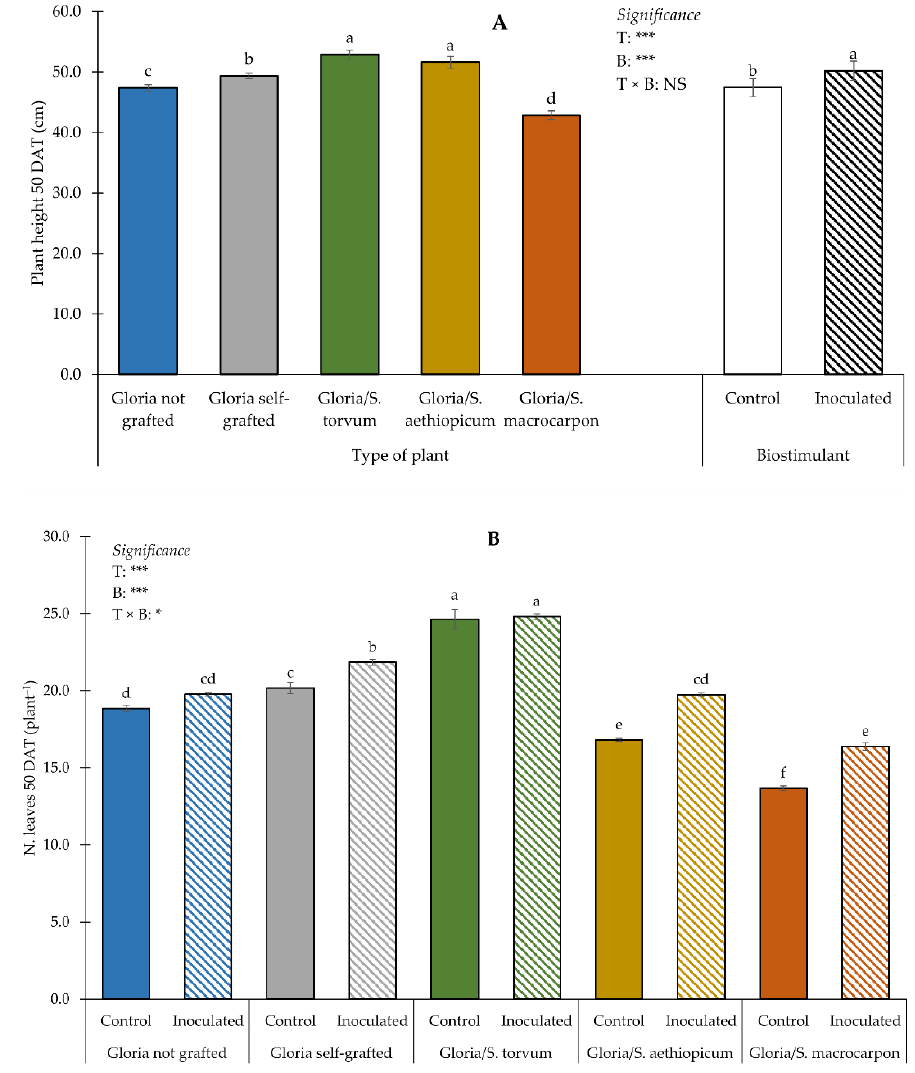
Figure 1. Influences of the type of plant and biostimulant application on plant height 50 days after transplanting (DAT) ( A ), and the number of leaves 50 DAT ( B ) of eggplant. Mean values with different letters are significantly dissimilar at p ≤ 0.05 , according to Tukey ’s test. NS = not significant; * = significant at p ≤ 0.05; *** = significant at p ≤ 0.001. Bars indicate the means ± standard error.